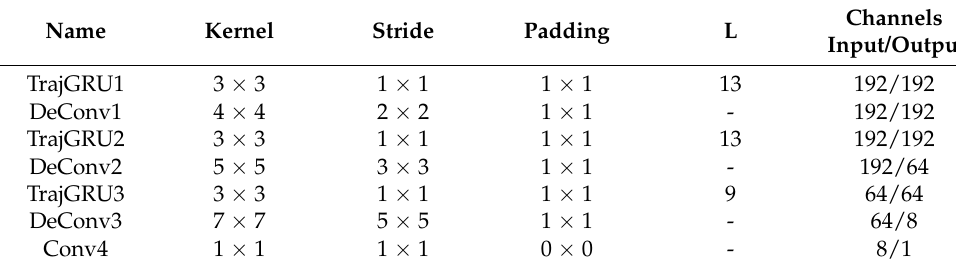
Table 2. Forecaster part in the first stage prediction